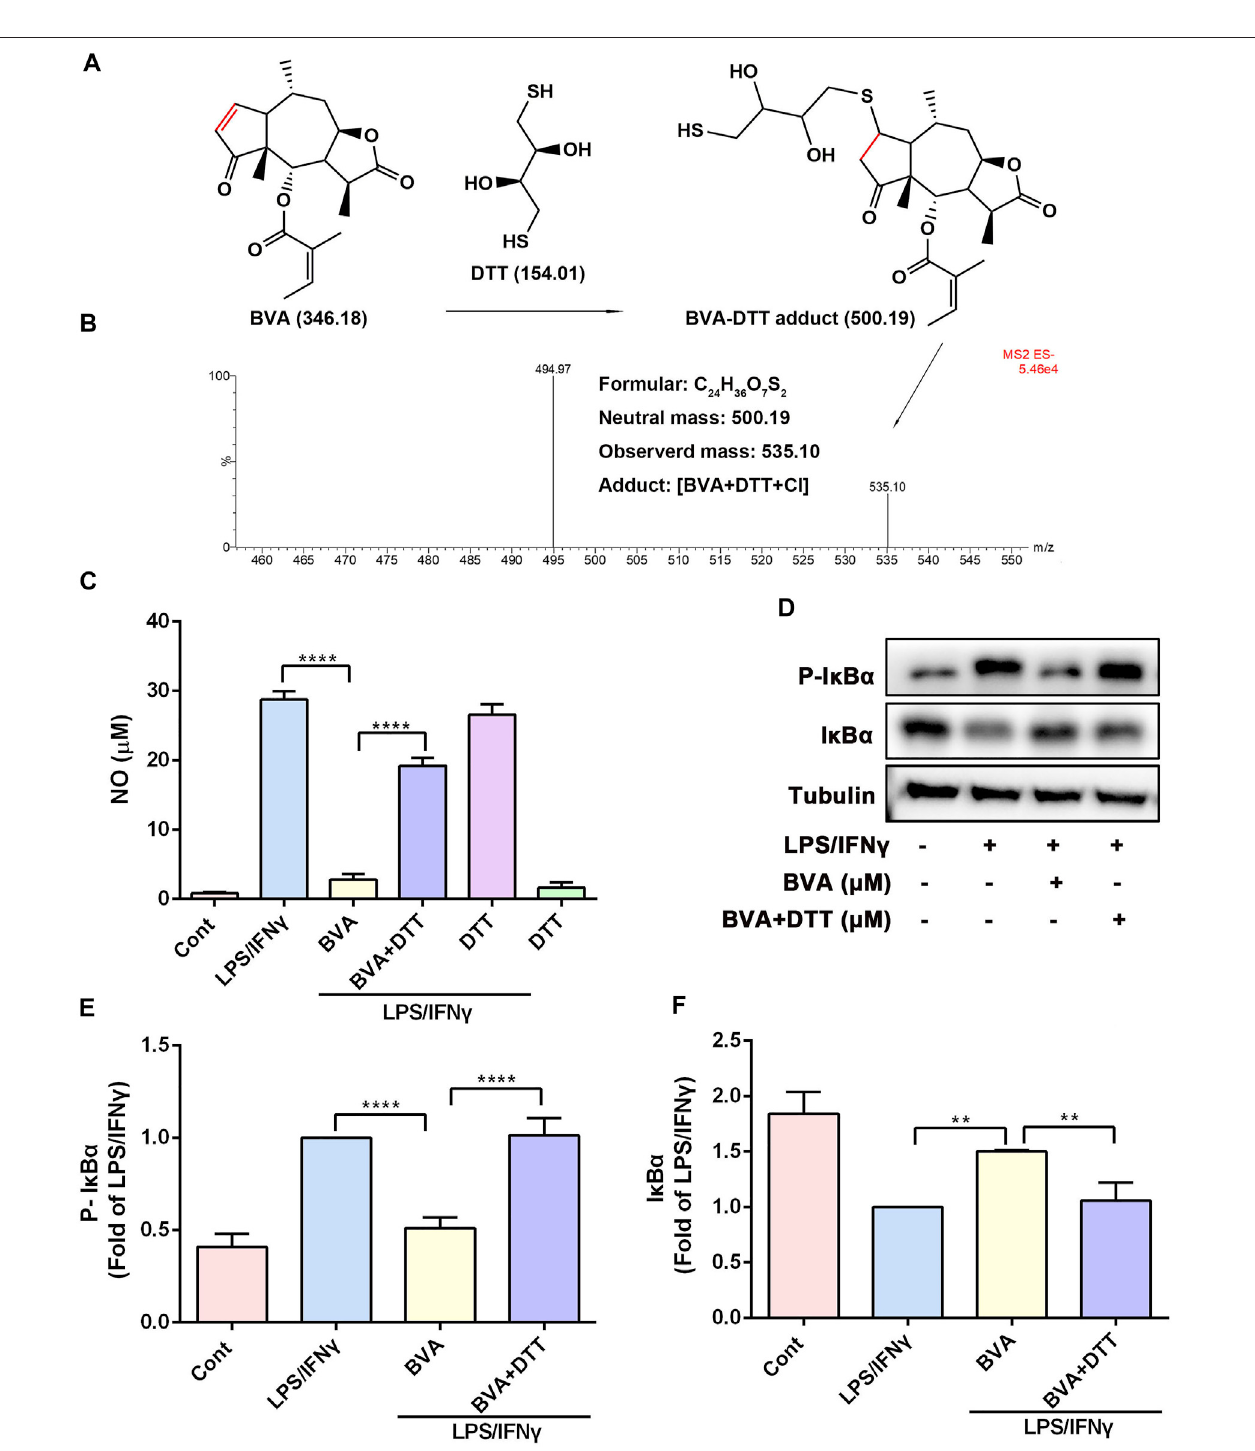
FIGURE 5| The α , β -unsaturated ketone moiety ofbrevilinA is crucial for its anti-in fl ammatoryactivity in vitro. (A) Michael addition reaction between BVA and DTT. (B) The adduct product of BVA and DTT was analyzed by LC-MS. Molecular weights of the molecules are indicated. (C) The comparison of DTT-treated and vehicle- treatedBVAon NOproduction inLPS/IFN γ -stimulated RAW264.7cells. (D) RAW264.7cellsweretreatedwithBVA orDTT-incubated BVA for2 h, andthen exposedto LPS/IFN γ for 5 min. Then, the levels of p-I κ B α and I κ B α , as well as Tubulin were detected by immunoblotting. Densitometry analysis of p-I κ B α (E) and I κ B α (F) normalized against Tubulin, respectively. * p < 0.05, ** p < 0.01, *** p < 0.001, **** p < 0.0001, vs. BVA.